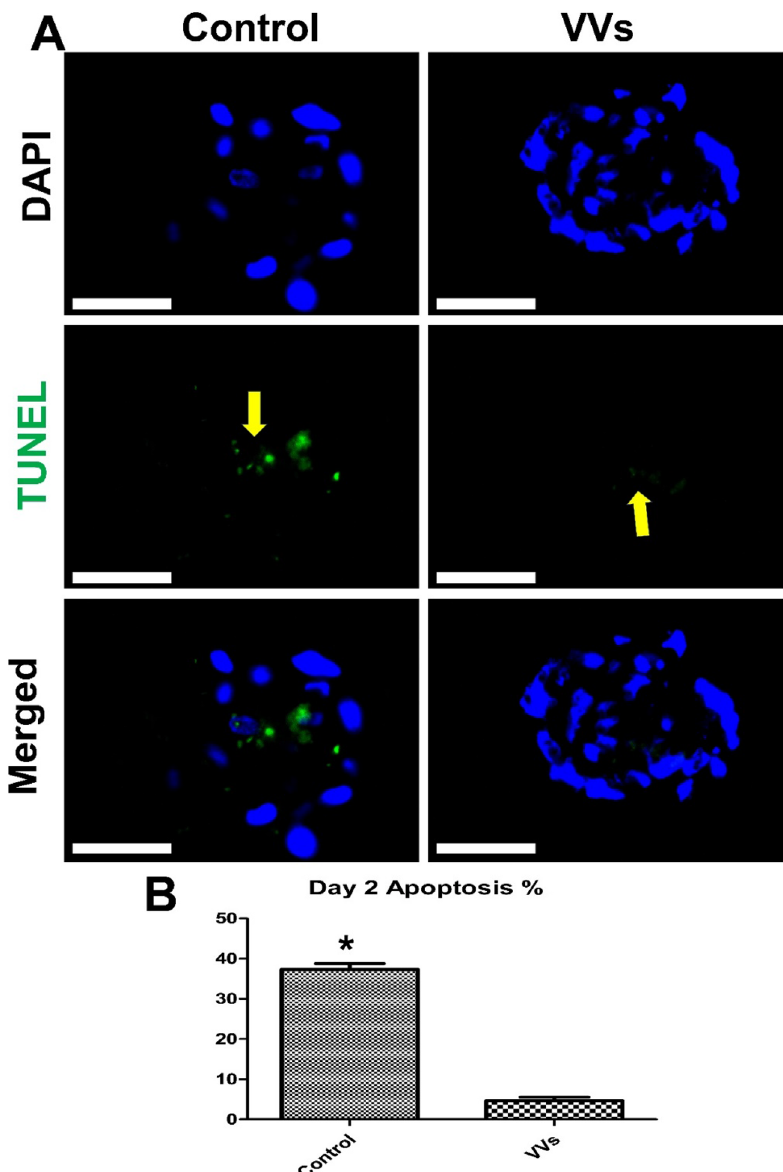
Figure 5. Effects of VVs on porcine embryo apoptosis. ( A ) Day-7 zona-free embryos (n = 20, 3 replicates) were cultured on in micro drops of culture medium in a humidified atmosphere of 5% CO 2 for 48 h. VVs of 2.6 × 10 6 particles/mL were supplemented to treatment group and compared with the control non-supplemented group. All groups were examined through TUNEL assay and contrasted with 4 ′ ,6-diamidino-2-phenylindole stain. Apoptotic nuclei showed green fluorescence signals (yellow arrows). Scale bar = 100 µm. ( B ) The graph shows the apoptosis percentage in the two groups, and values were compared using Student’s t-test. Value (mean ± SD) denoted by an asterisk (*) was considered statistically different ( p <